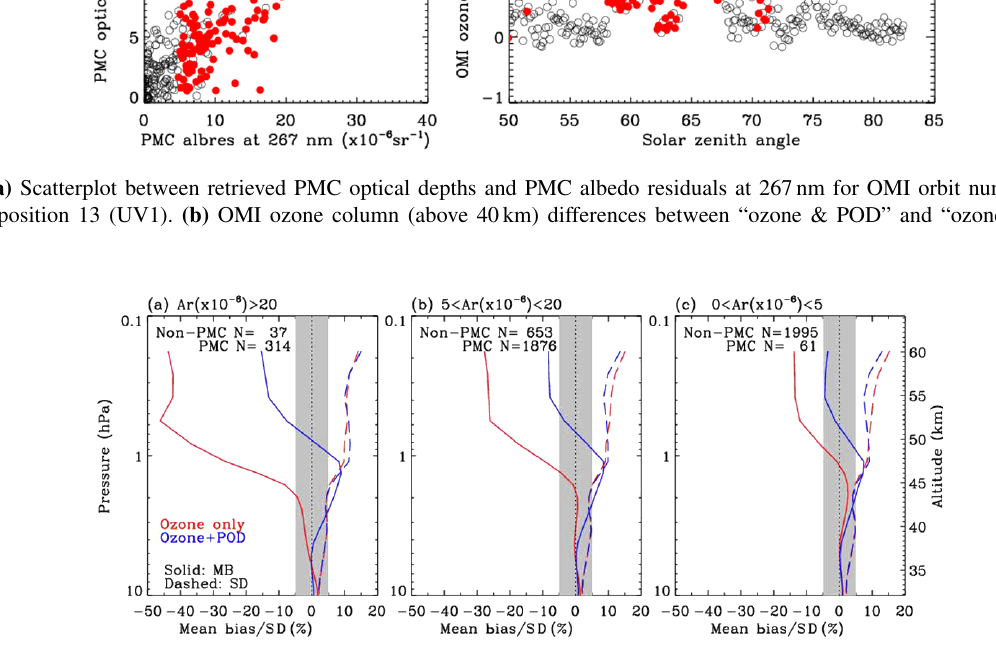
Figure 10. Collocated OMI–convolved MLS profile differences (solid lines) and their 1 σ standard deviations (dashed lines) for different ranges of PMC albedo residual (Ar) values (sr − 1 ) at 267nm for the NH 2007 summer season. The blue and red lines represent the com- parisons when OMI ozone profiles are retrieved with and without PODs, respectively. The numbers of the non-PMC and PMC pixels are included as